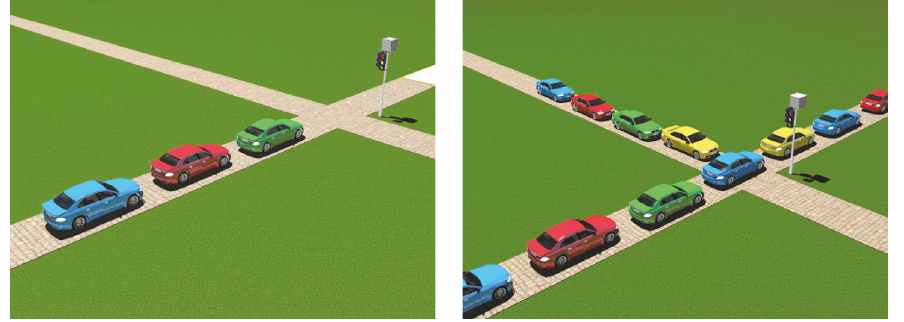
Figure 1: Two disadvantages of the green wave method.